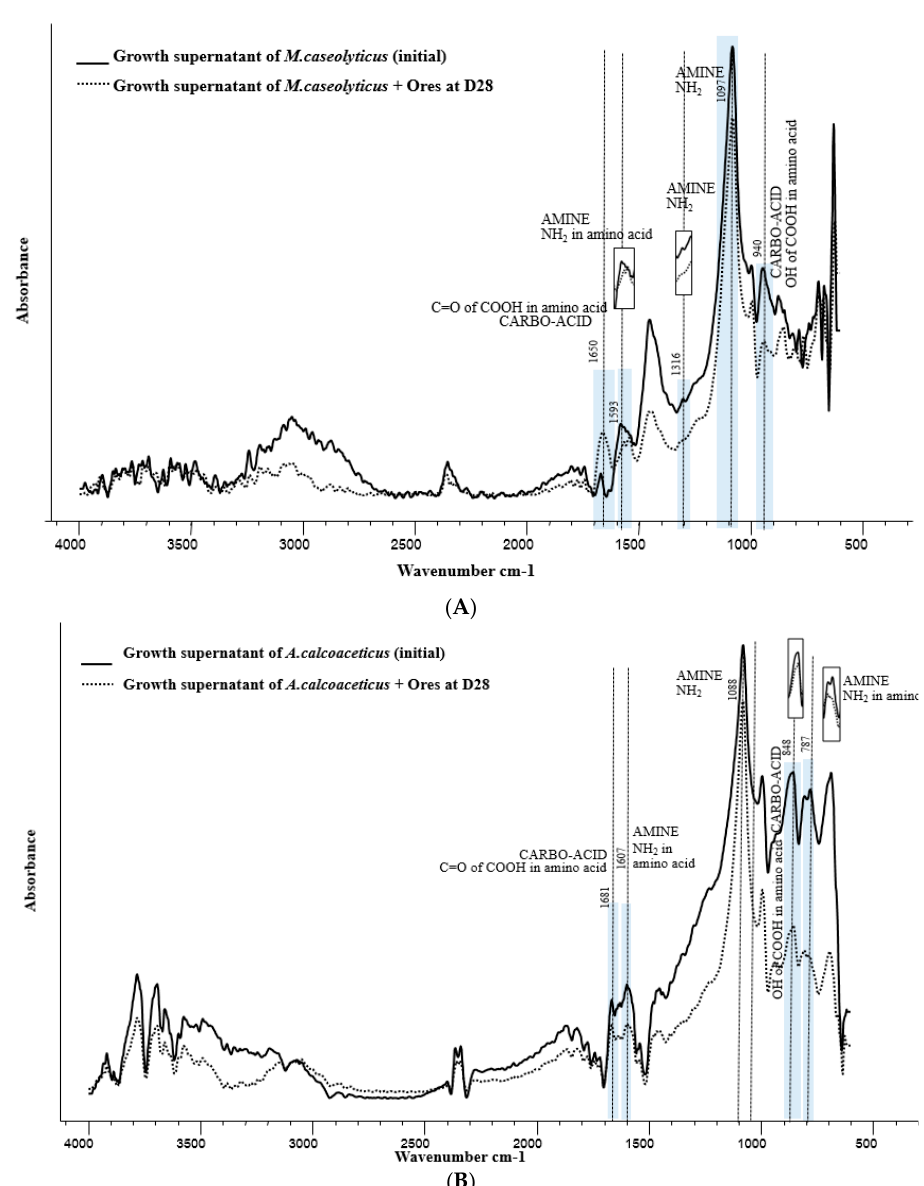
Figure 5. FTIR spectra of growth supernatant (GS) of M. caseolyticus ( A ) and A. calcoalyticus ( B ) before and after gold bioleaching.